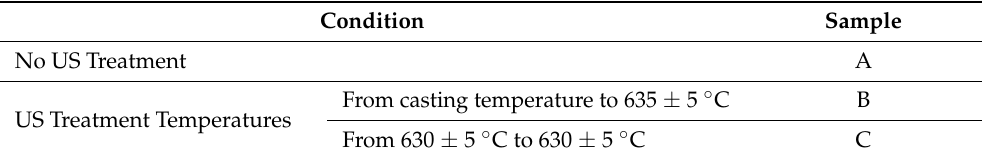
Table 2. Processing conditions of the samples .